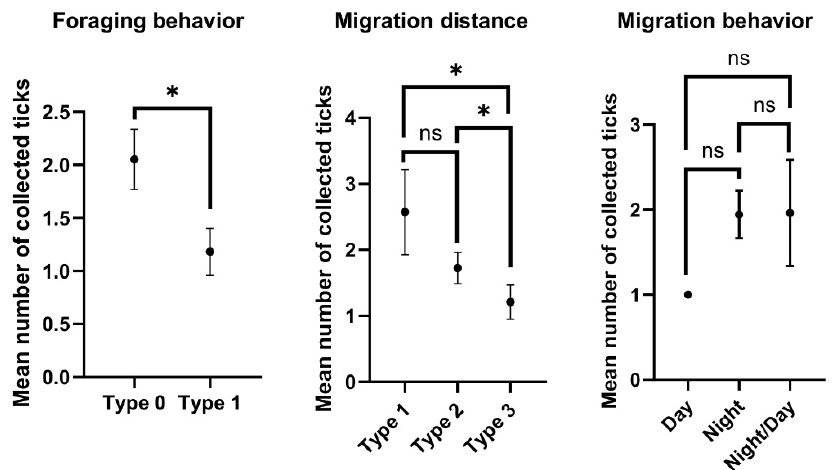
Figure 4. Mean intensity of tick infestation depending on the birds’ behavior (including the 95% confidence interval), *—statistically significant differences, ns—statistically insignificant differences.